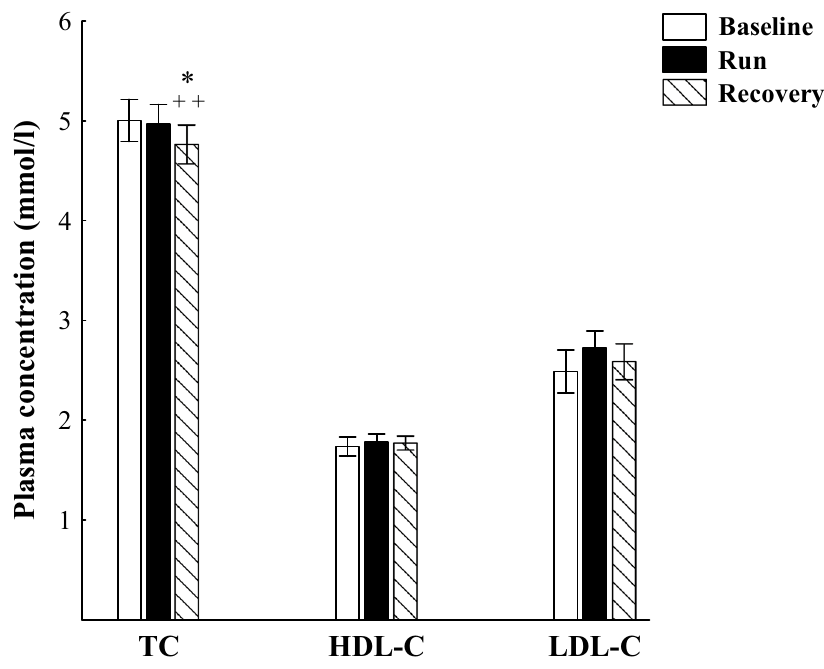
Figure 2. The plasma concentration of total cholesterol (TC), high-density lipoprotein-cholesterol (HDL-C) and low-density lipoprotein-cholesterol (LDL-C) before (Baseline), immediately after marathon run (Run) and at the 90 min of recovery (Recovery). The values are mean ± SEM ( n = 11). Asterisks denote significant differences from the resting values: *P < 0.02. Crosses denote significant differences from the exercise values: ++ P < 0.01.